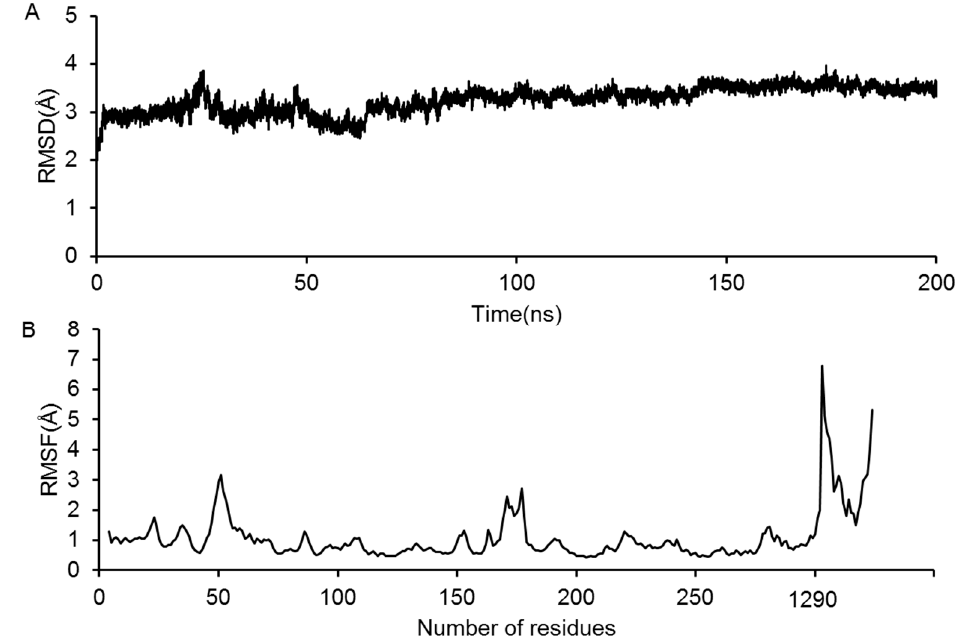
Figure 5. ( A ) The monitored root-mean-square-deviation (RMSD) of the all atoms with respect to the initial structure during the 200 ns simulation. ( B ) The root-mean-square-fluctuation (RMSF) value of backbone atoms of complex 1 during the 200 ns